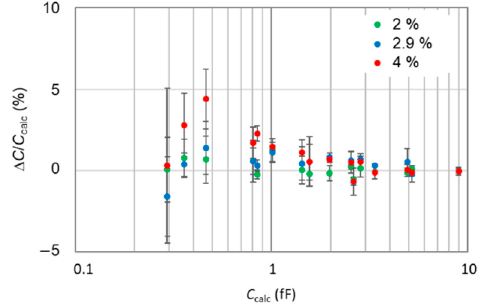
Figure 5. Relative differences between measured capacitances on the pattern A64-I05 at RH = 2%, 2.9% and 4% and capacitances measured at RH = 0.9%. Each datum represents the mean value of capacitances of 3 capacitors of same area and on same plateau. The error bars correspond to the standard deviation.